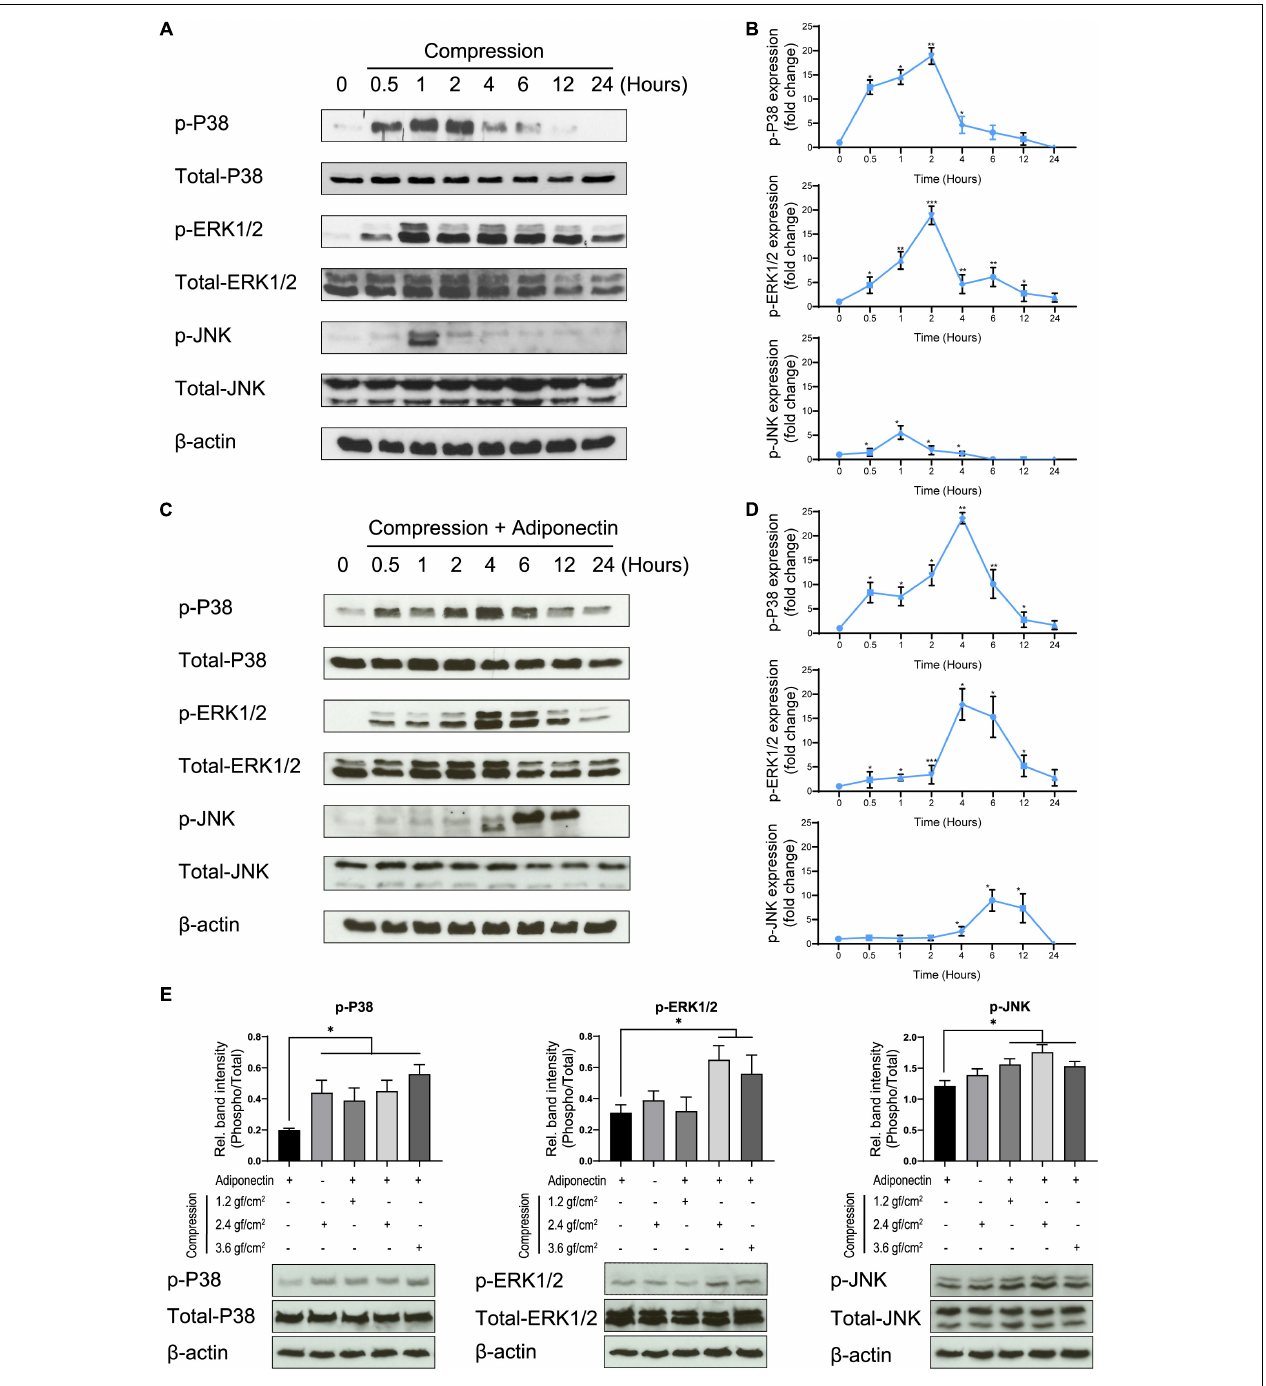
FIGURE 2 | Adiponectin in combination with compression enhances MAPK signaling activation. (A,B) Compression promotes P38, ERK1/2, and JNK phosphorylation on OCCM-30 cells. The kinetic protein expression of P38, ERK1/2, and JNK as well as their phosphorylated forms in response to compressive forces of 2.4 gf/cm 2 were analyzed by western blots. β -Actin served as a loading control. (C,D) After stimulation with 2.4 gf/cm 2 compression and adiponectin (100 ng/ml), phosphorylated forms of P38, ERK1/2, and JNK were up-regulated at different time points. Graphics represent the relative expression values of p-P38, p-ERK1/2, and p-JNK normalized to control cells at time point 0 as protein fold changes, respectively. (E) Western blot showing the expression changes of MAPK protein induced by adiponectin (100 ng/ml), compression (2.4 gf/cm 2 ), or adiponectin combined with compression (1.2, 2.4, and 3.6 gf/cm 2 ). The quantification ratio of p-P38, p-ERK1/2, and p-JNK is shown as phosphorylated state unit/total unphosphorylated protein (Phospho/Total). The statistical analysis was based on three independent experiments. Values are shown as the means ± SD. Asterisks indicate significant differences compared to control cells (*** p < 0.001, ** p < 0.01, and * p < 0.05; ns, not